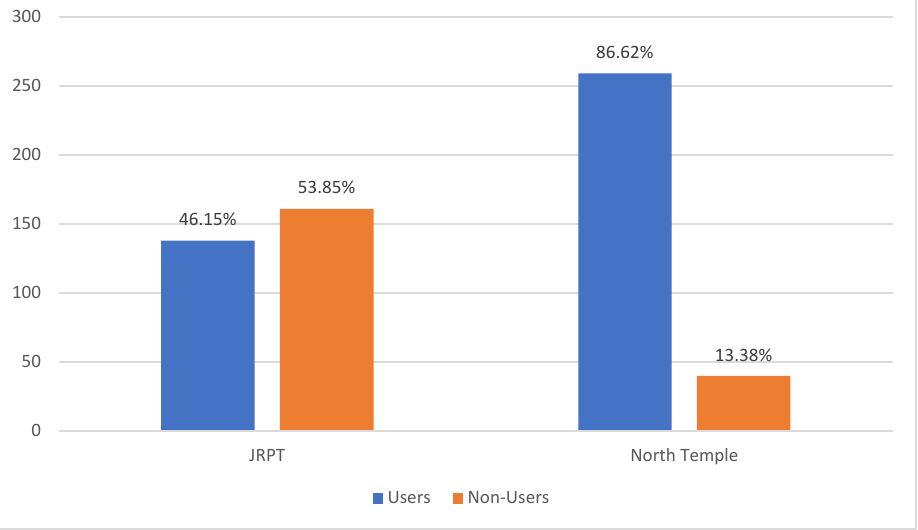
Figure 2. Active and public transportation users by corridor. source: created by authors for this paper.